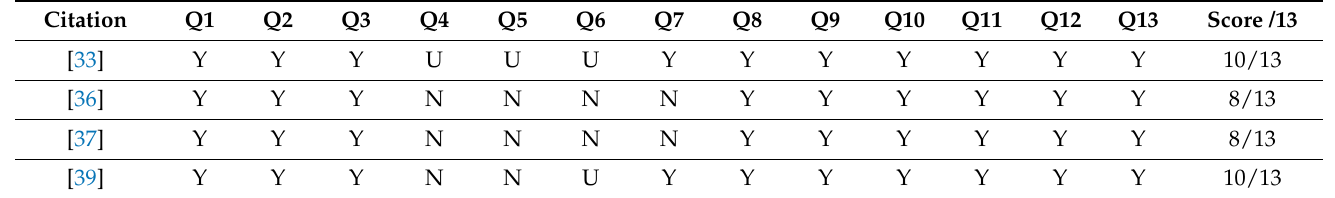
Table 3. JBI Critical Appraisal Checklist for randomised controlled trial